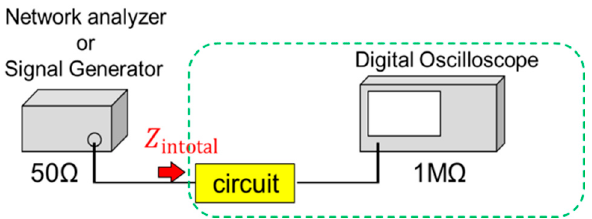
Figure 6. Simplified diagram of measurement.